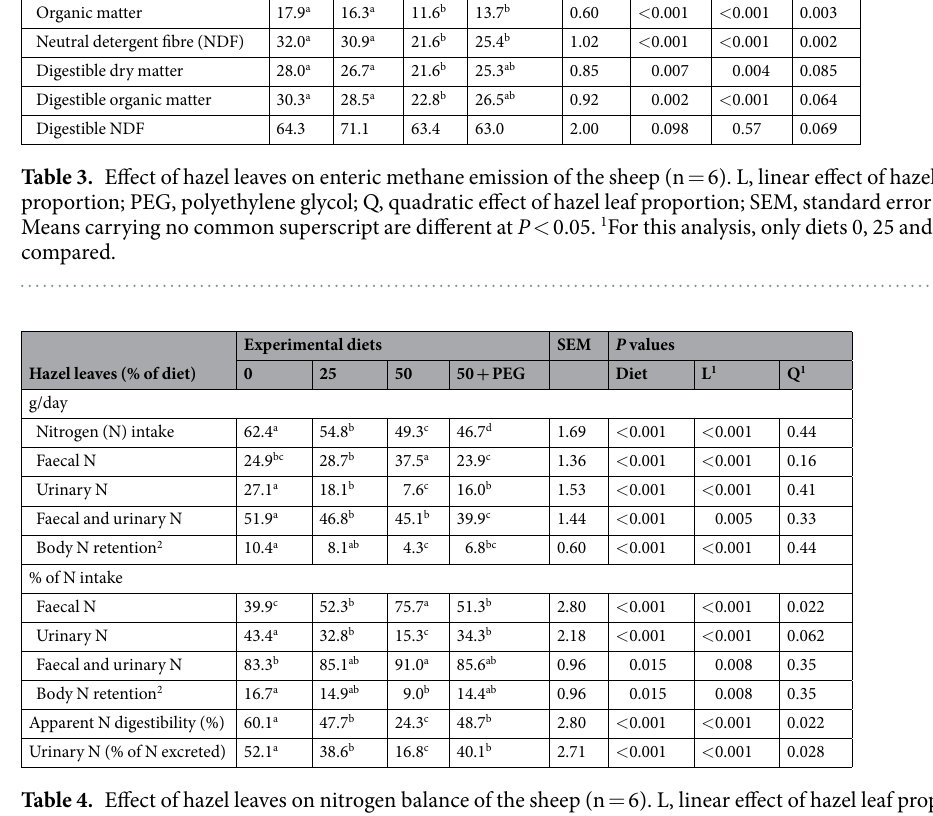
Table 4. Effect of hazel leaves on nitrogen balance of the sheep (n = 6). L, linear effect of hazel leaf proportion; PEG, polyethylene glycol; Q, quadratic effect of hazel leaf proportion; SEM, standard error of mean. Means carrying no common superscript are different at P < 0.05. 1 For this analysis, only diets 0, 25 and 50 were compared. 2 Including N in wool grown during the